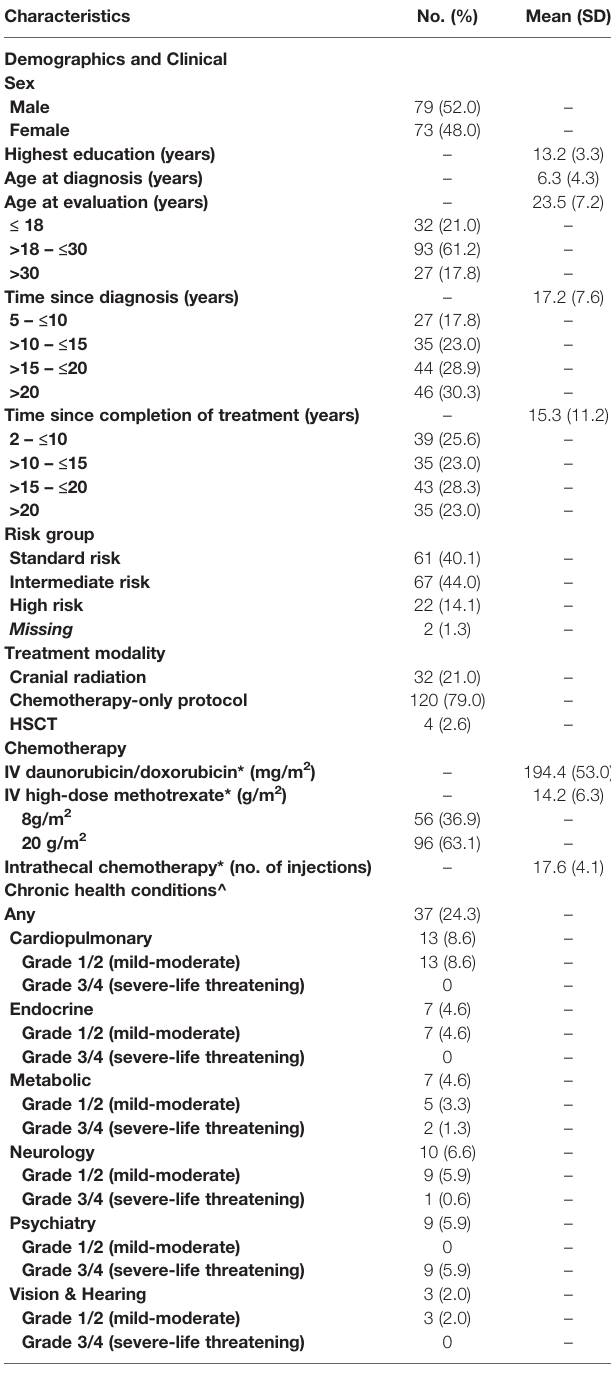
TABLE 1 | Clinical and Treatment Characteristics of Study Cohort